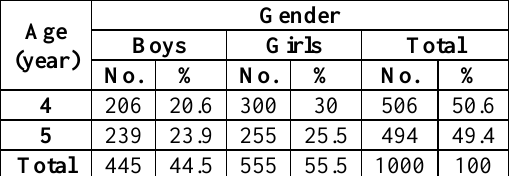
Table 1: The distribution of total sample by age and gender